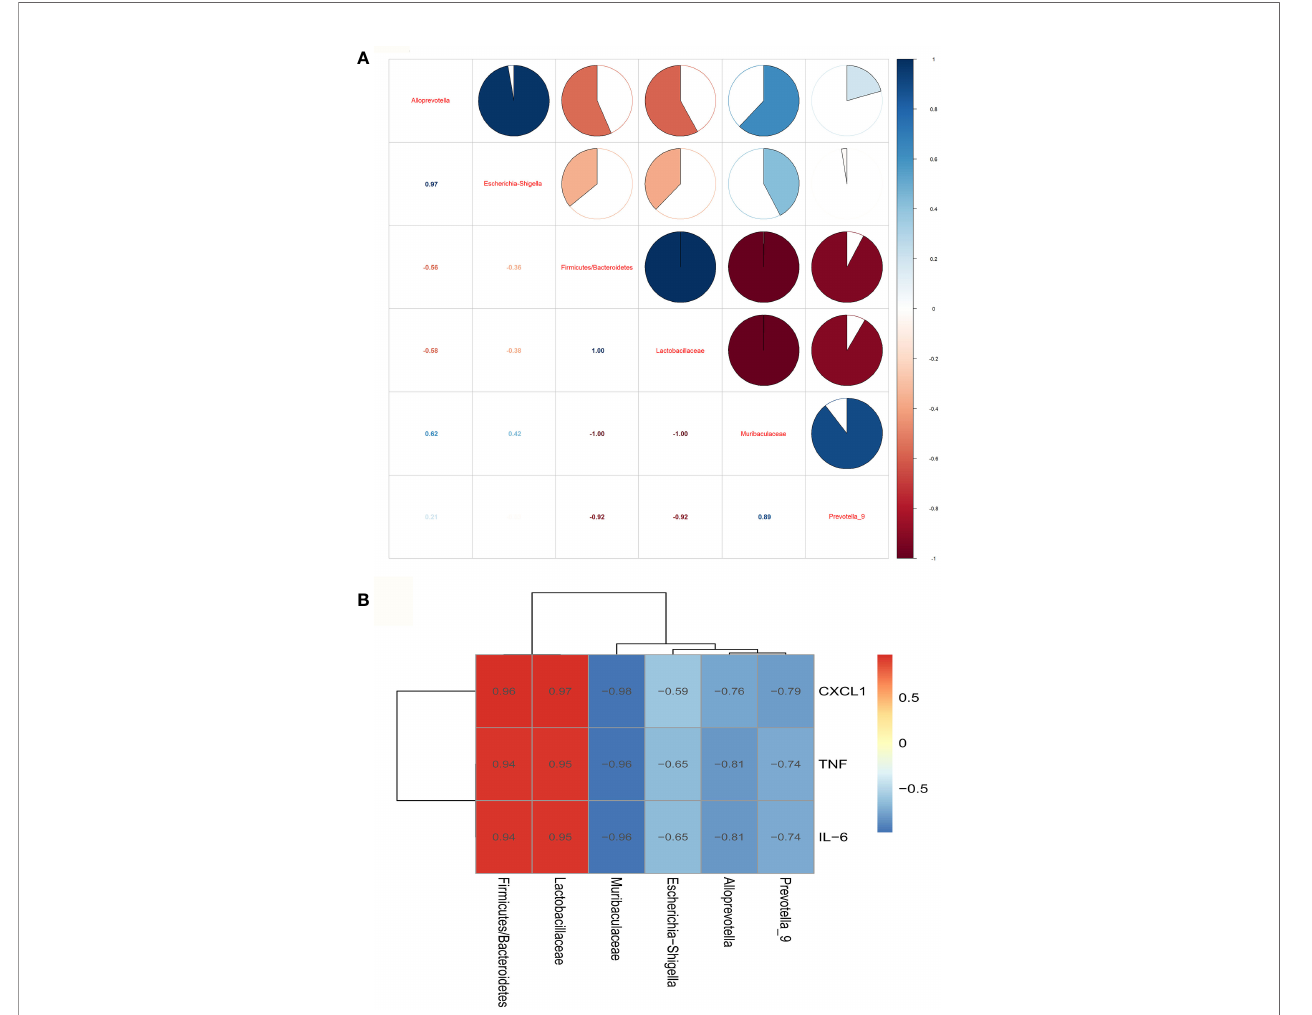
FIGURE 4 | The correlation analysis of the gut microbiota and in fl ammation of the brain of septic rats. (A) The correlation analysis of the gut microbiota showed that Muribaculaceae and Alloprevot_9 were negatively correlated to Firmicutes/Bacteroidetes and Lactobacillaceae , and Muribaculaceae was positively correlated to Alloprevot_9 .Interestingly, Escherichia_Shigella showed a positive correlation to Alloprevotella. (B) The correlation analysis between gut microbiota and brain in fl ammation showed that Firmicutes/Bacteroidetes and Lactobacillaceae were positively and Alloprevotella , Muribaculaceae , Prevotella_9, and Escherichia_Shigella were negatively correlated to TNF, IL-6, and CXCL1. TNF:TNF- a